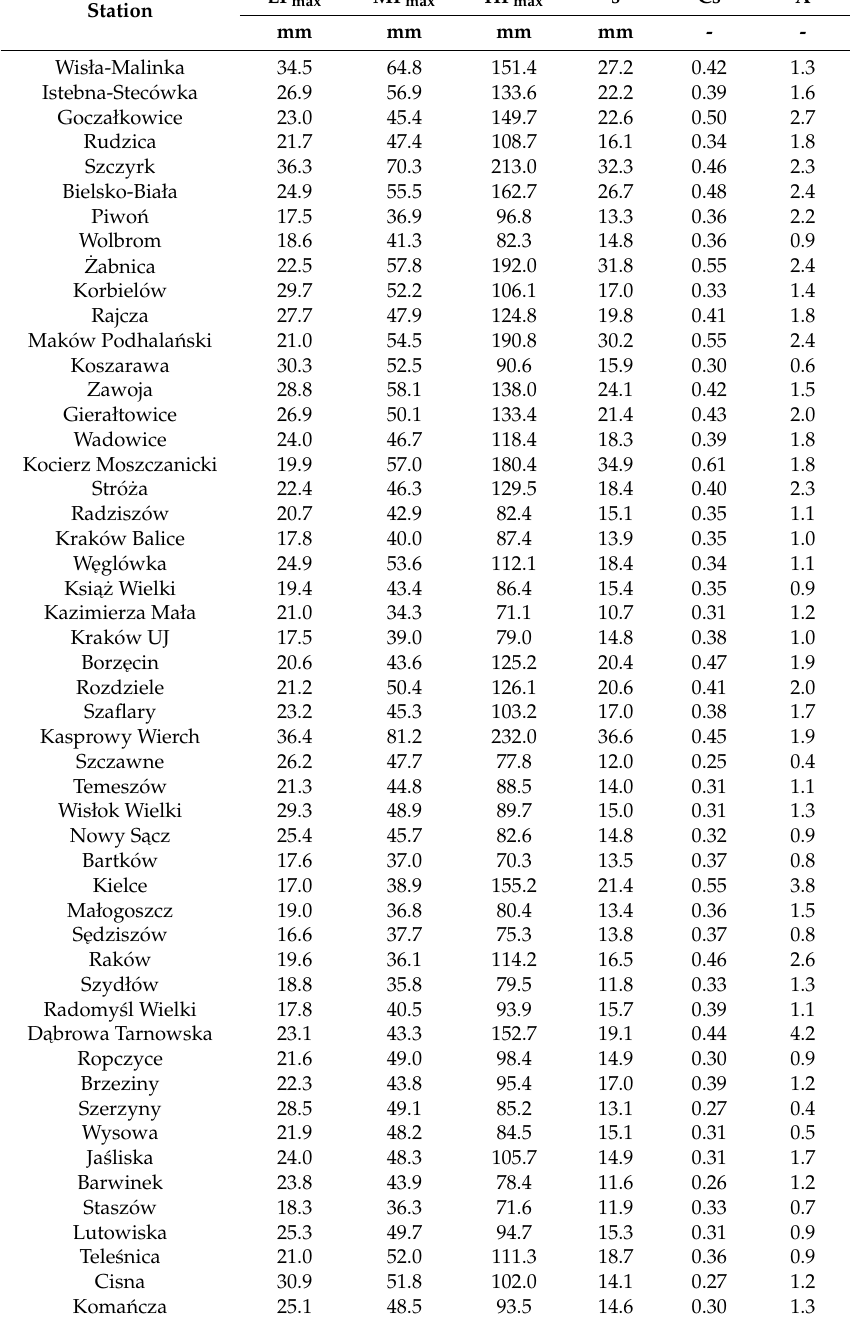
Table 1. The characteristics of the annual maximum precipitation in the analyzed